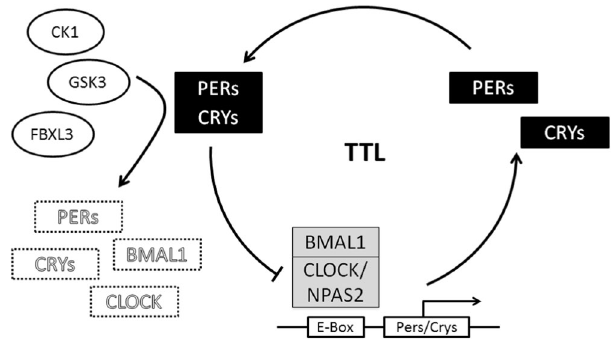
Fig. 2 The circadian transcription/translation loop is comprised of rhythmically expressed “ clock genes ” . Circadian protein complexes containing BMAL1 drive expression of rhythmic genes including period (PER) and cryptochrome (CRY) through E-box DNA elements in promoters. PER/CRY negatively regulate their own expression. As PER/CRY degrade over several hours, BMAL1 activity increases and the cycle repeats. Time of onset (phase), duration (period), and strength (amplitude) of the cycle is regulated by multiple signaling pathway inputs. The fi gure was adapted from Landgraf et al . [ Behavioral Neuroscience 128(3): 344 – 359, 2014] with permission